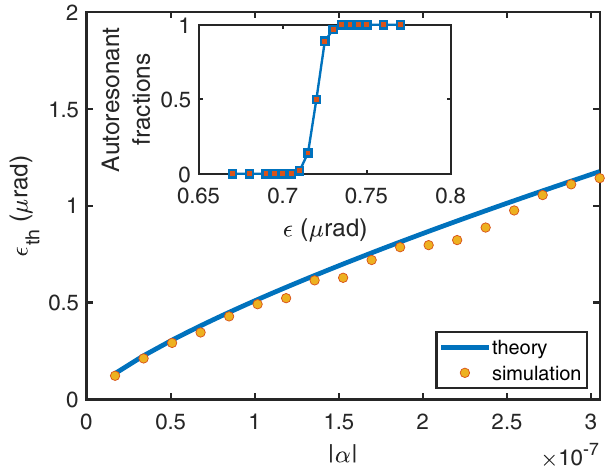
FIG. 3. Comparison of the drive amplitude threshold depend- ence on the sweep rate in simulation and in theory for the undamped simple model. Inset plot: autoresonant fractions versus drive amplitudes near the